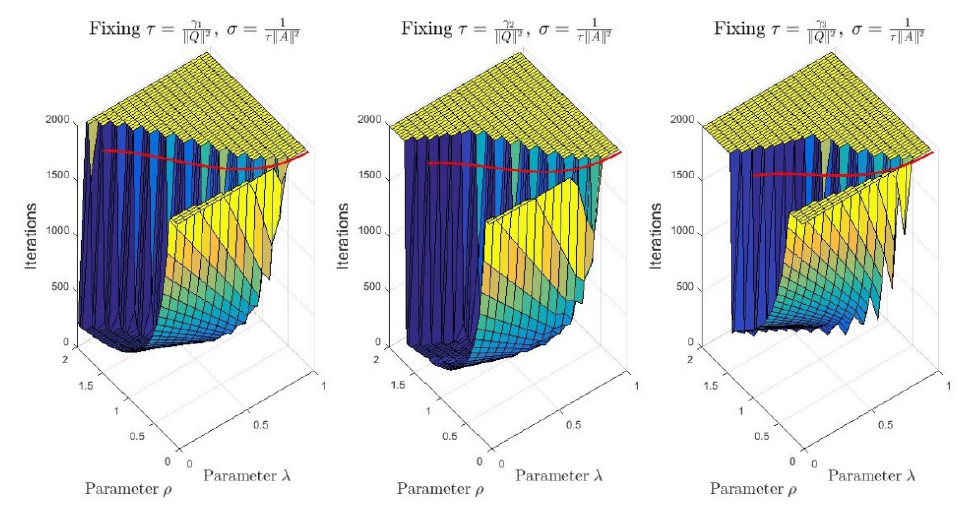
Figure 4 Varying λ and